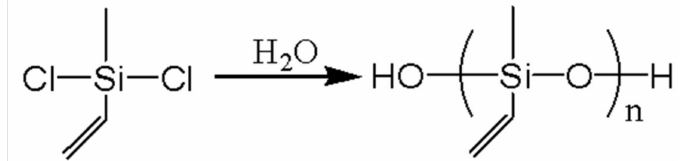
Figure 2. Preparation of PMVS by hydrolysis